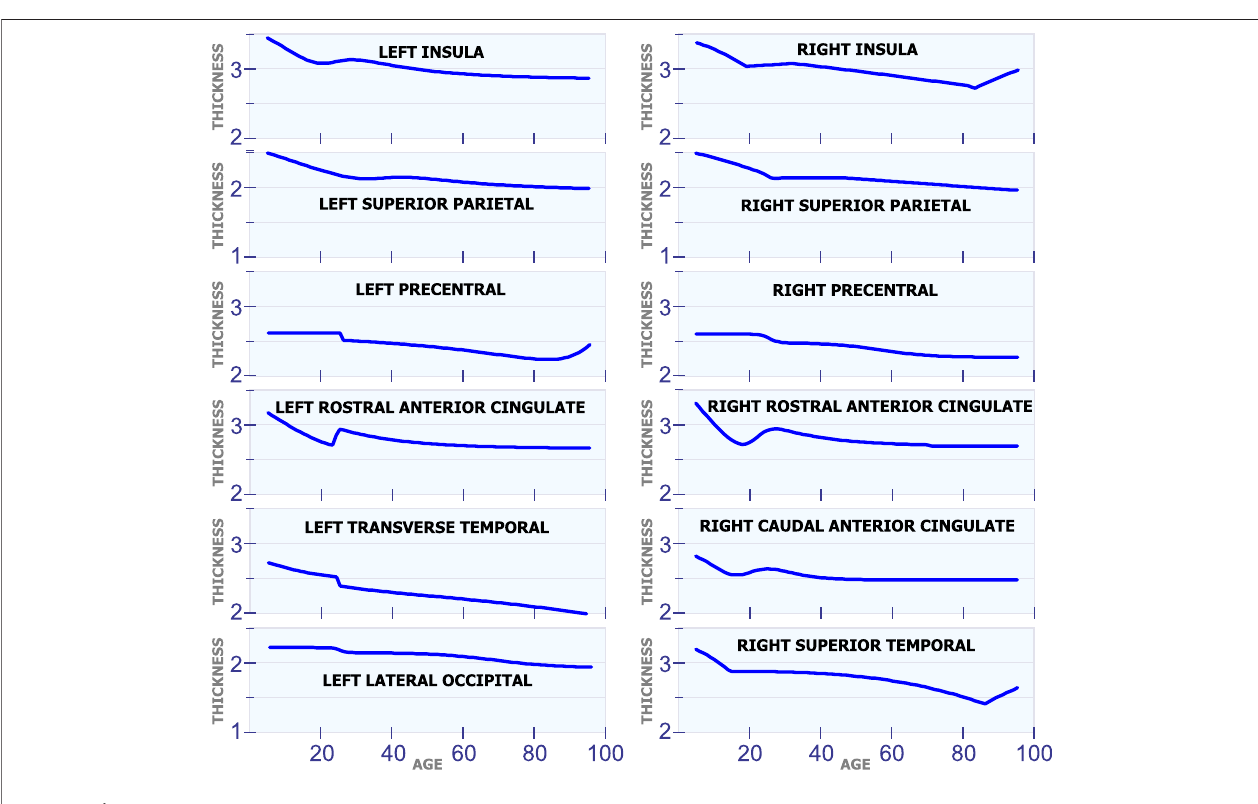
FIGURE 2 | Regions with changes in cortical thickness around 25 years of age.